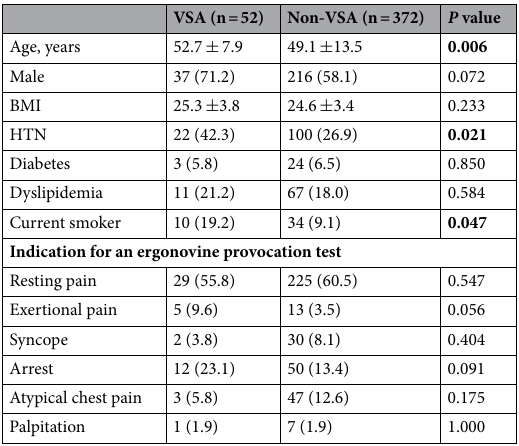
Table 1. Baseline characteristics and indication for ergonovine provocation test between VSA and non- VSA groups. Data are expressed as number (percentages) or mean ± standard deviation. Abbreviations: VSA vasospastic angina, BMI body mass index, HTN hypertension. Significant values are in [bold].